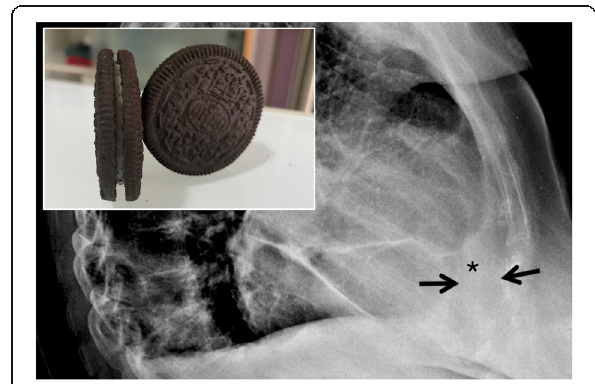
Fig. 26 Popcorn calcification. Popcorn calcifications may be encountered in cases of patients with pulmonary hamartoma. The figure shows the presence of a pulmonary hamartoma, which is characterized by the presence of fat and amorphous calcification (white arrow), which remind us of the appearance of a piece of popcorn